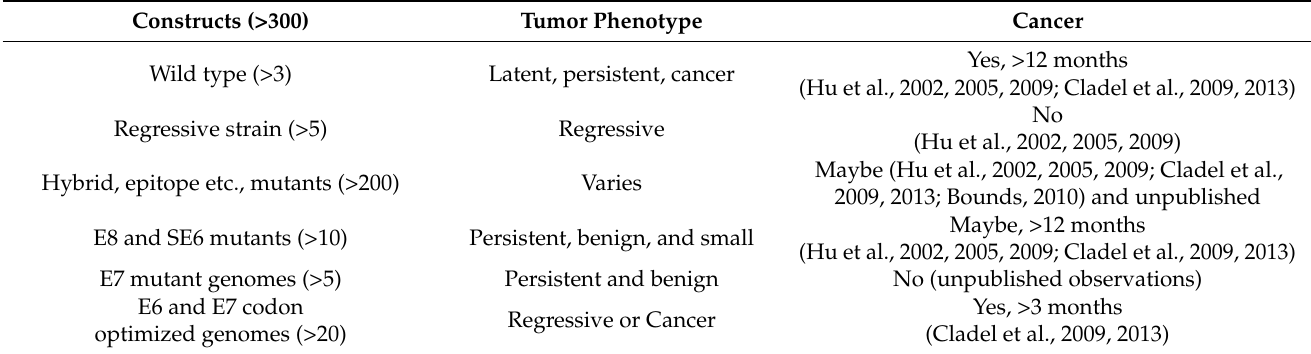
Table 1. Published mutant CRPV genomes with unique phenotypes.